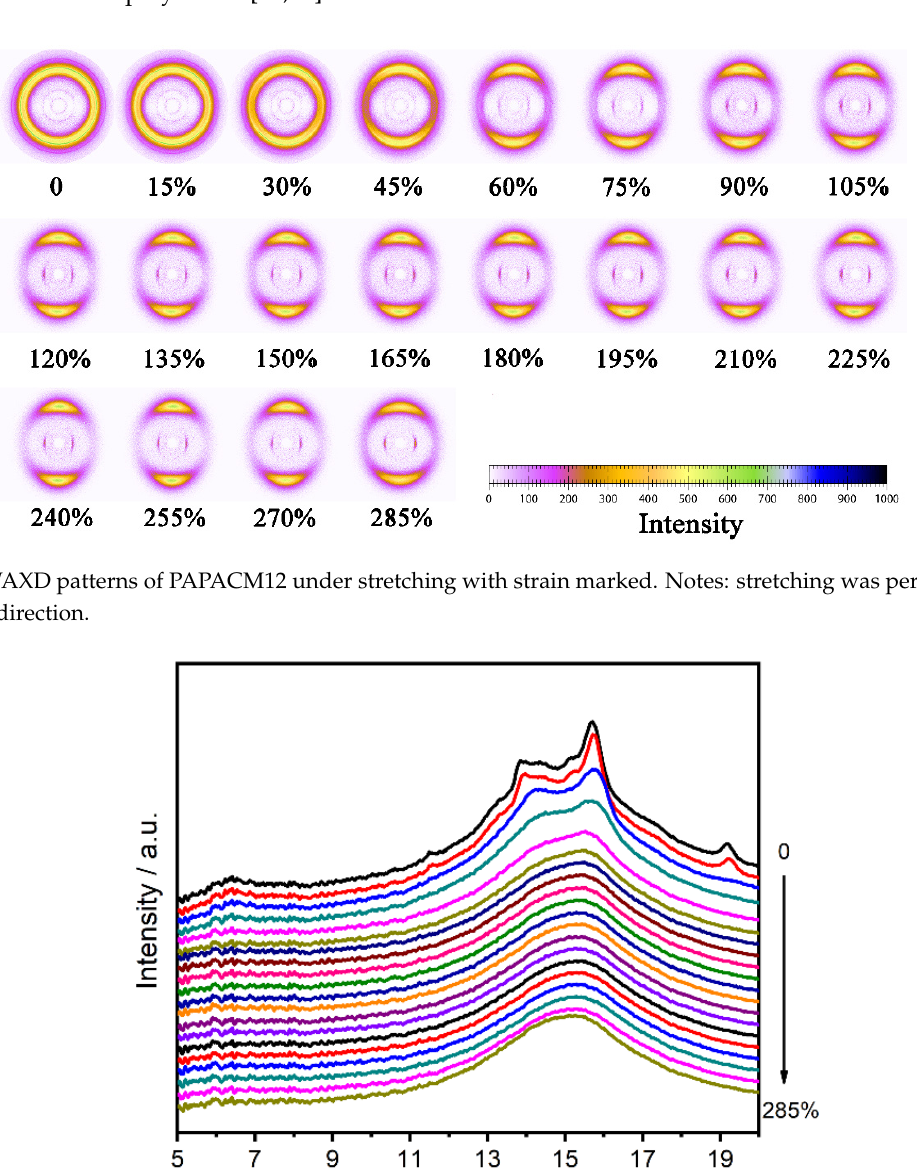
Figure 6. MDSC curves of PAPACM12 under different strain during cooling: ( a ) reversible signal,